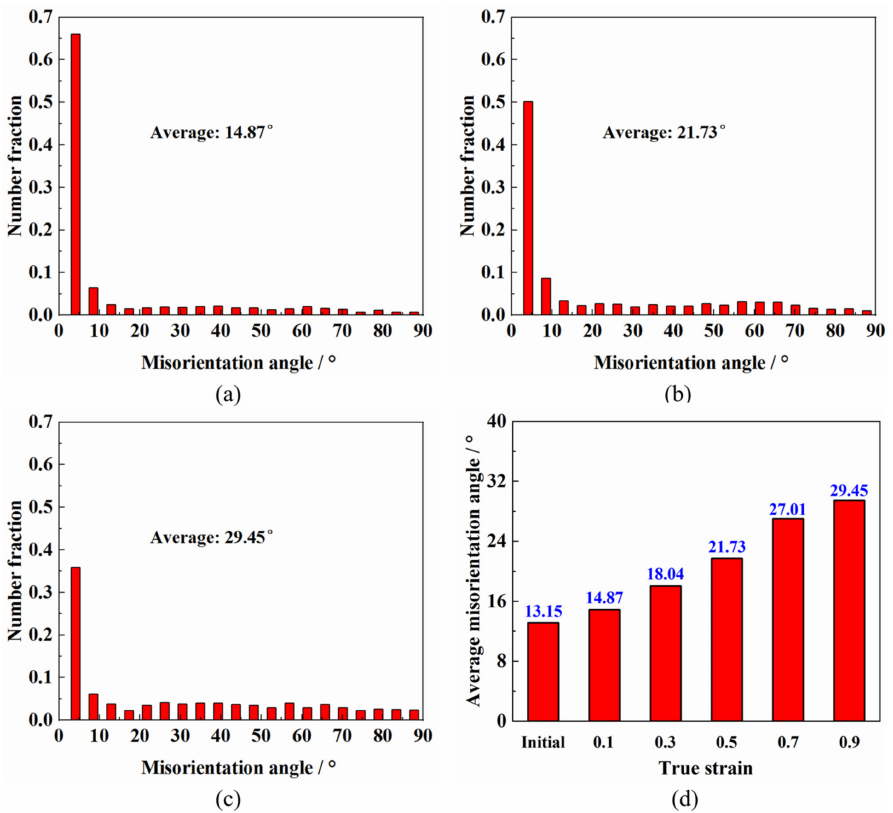
Figure 13. The distributions of the misorientation angle at different strains when deformed at 950 ◦ C and 0.01 s − 1 : ( a ) 0.1; ( b ) 0.5; ( c ) 0.9; ( d ) the evolution of the average misorientation angle with